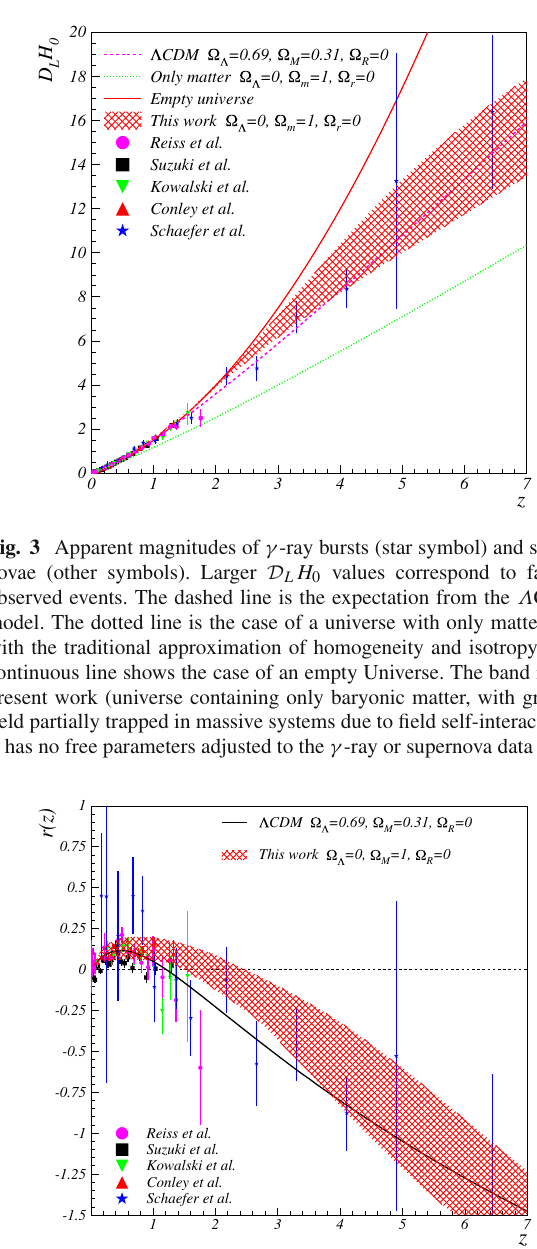
Fig. 4 Residual between observed apparent magnitudes ( γ -ray bursts: star symbol. Supernovae: other symbols) and their expectation from an empty universe. The continuous line is for the Λ CDM model. The band is the present work, without any free parameters adjusted to the γ -ray or supernova